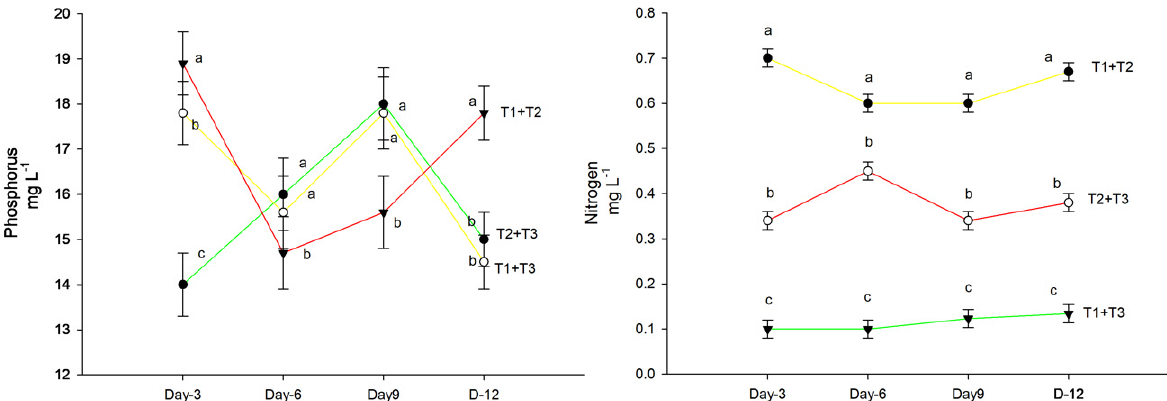
Figure 6. Dynamic of solubilized phosphorus and fixed nitrogen content from the test tube every three days with the mixture of bacteria. T1 = B. cereus ; T2 = S. dextrinosolvens , and T3 = L . acidophilus . Means with different letters indicate significant differences among treatments. Statistical analysis was performed using Duncan’s test ( p < 0.05). Black triangle = T1 + T2; black circle = T2 + T3; white circle = T1 + T3.